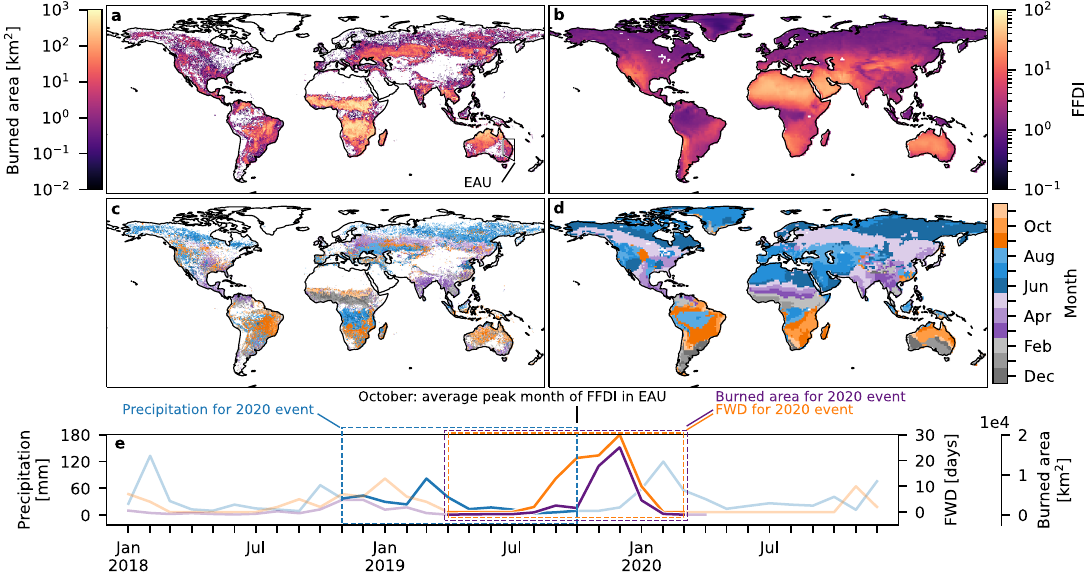
Fig. 1 FFDI and burned area climatology 2001 – 2019, and event de fi nitions. a Average annual burned area (km 2 ). b Average daily FFDI. c Month of maximum average burned area. d Month of maximum average FFDI. e Example of which months are used in the calculation of annual values of precipitation, burned area and fi re weather days (FWD). The data are for the eastern Australia (EAU) region shown in ( a ). October is the month of average maximum FFDI. Therefore the 2020 event is de fi ned using the period November 2018 through October 2019 for precipitation, and April 2019 through March 2020 for FWD and burned